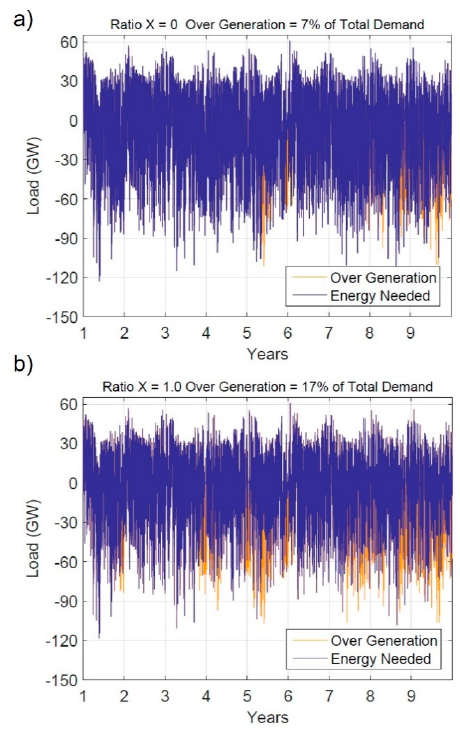
Figure 5. Examples of some profiles of net demand created for ( a ) X = 0 and ( b ) X = 1. The signal splitting or ‘filtering’ is an iterative process. The process stops when the energy content of C (profile for CAES) corresponds to the value defined for X . As men- tioned, the proportion of energy that the hydrogen store will receive is 1 − X. After the splitting the net-demand profile, the energy content of signal 𝐵 (profile for H 2 ) corre- sponds to the value of 1 − X.